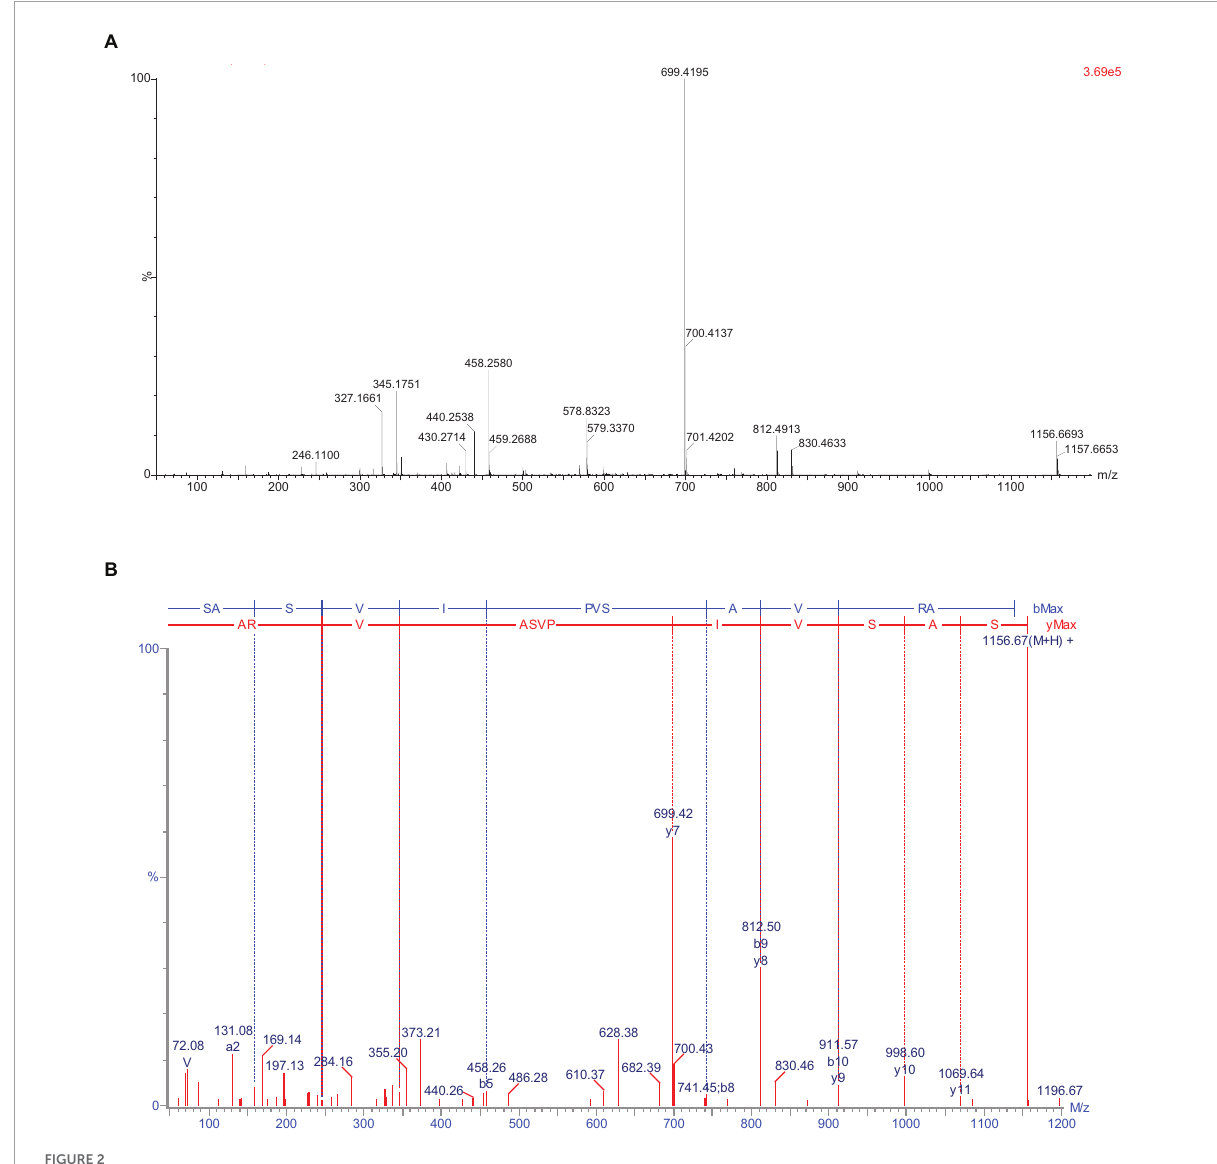
FIGURE2 The mass spectrum of the peptide SASVIPVSAVRA. (A) MS spectrum (B) MS/MS